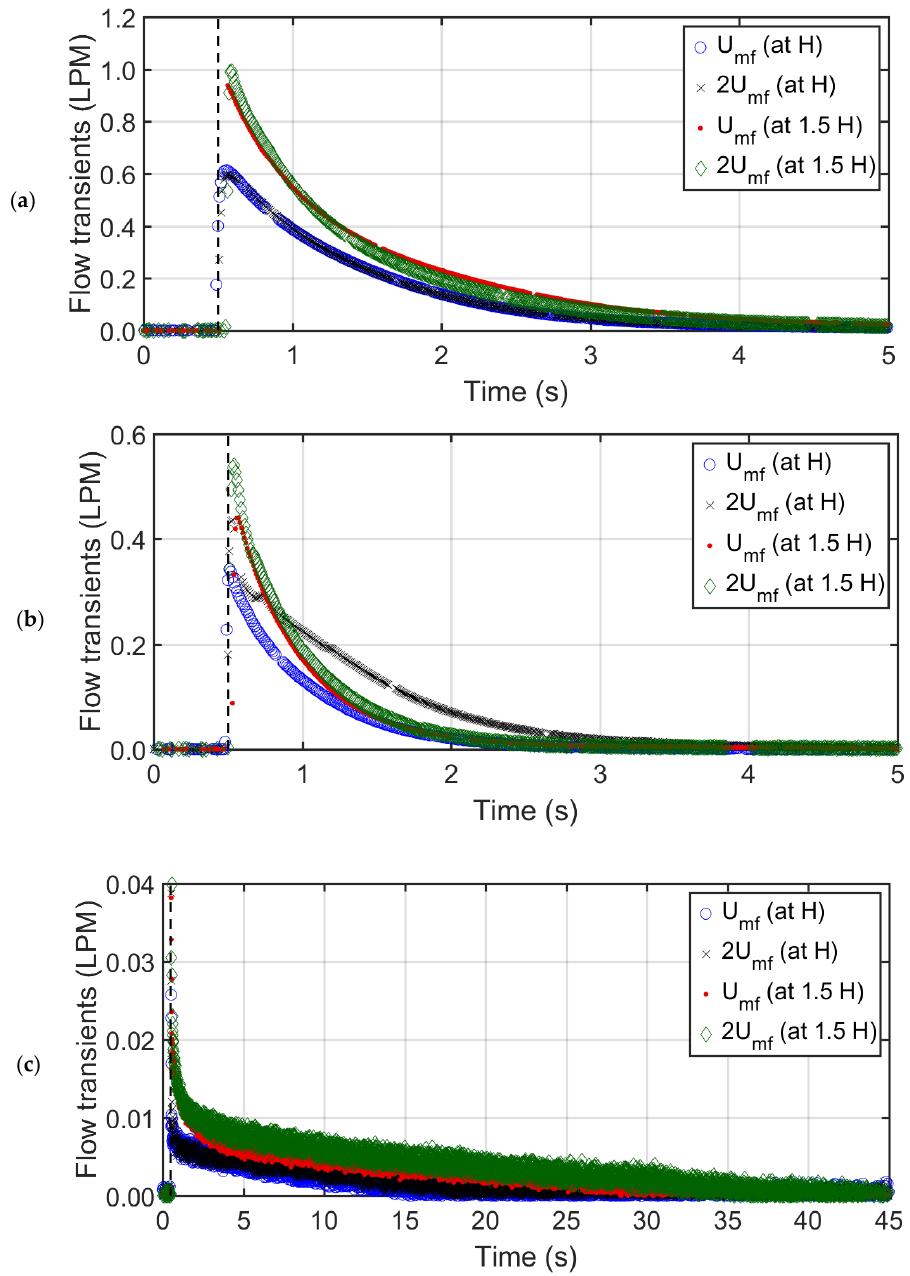
Figure 12. Purge flow transients at U mf and 2 U mf for ( a ) glass beads, ( b ) titania, and ( c ) nanosilica. The total airflow in LPM, which is the total area under the curve in Figure 12, was calculated using the trapezoid method. Thereafter, the ratio of the total airflow through purge to the volume of air that was present in the bed during the fluidization before the commencement of the collapse was calculated. The volume of air present in the bed re- sides in the voidage of the bed. Hence, bed voidage volume gives a good approximation of the total volume of air present under steady state. Figure 13 reports the plot of purge airflow ratio against the bed voidage. The relationship is linear with ‘ R 2 = 0.985 ’ fit, which signifies that the ratio of purge airflow with bed fluid volume during fluidization de- creases linearly with the bed voidage.